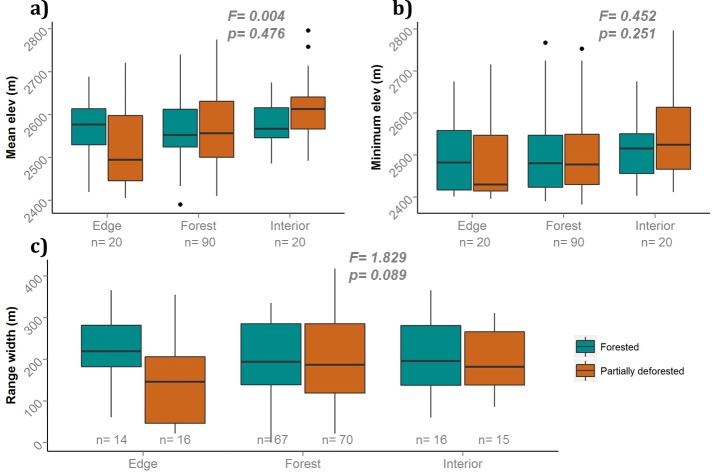
Comparison of elevational range variables per habitat preference category for forested and partially deforested transects (p values shown are for one-tailed two-factor ANOVAs).a) Abundance-weighted mean elevation. b) Minimum elevation. c) Elevational range width. Dots represent outliers.